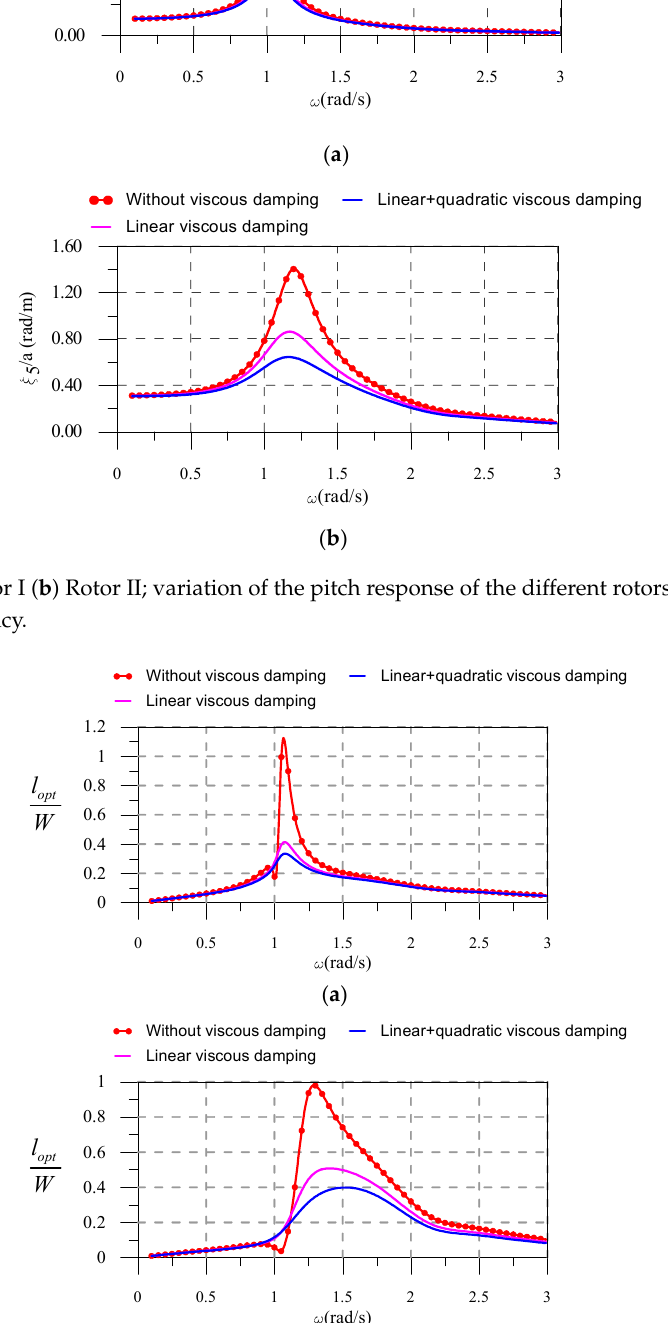
Figure 10. ( a ) Rotor I ( b ) Rotor II; Variation of non-dimensional capture width of the different rotors as